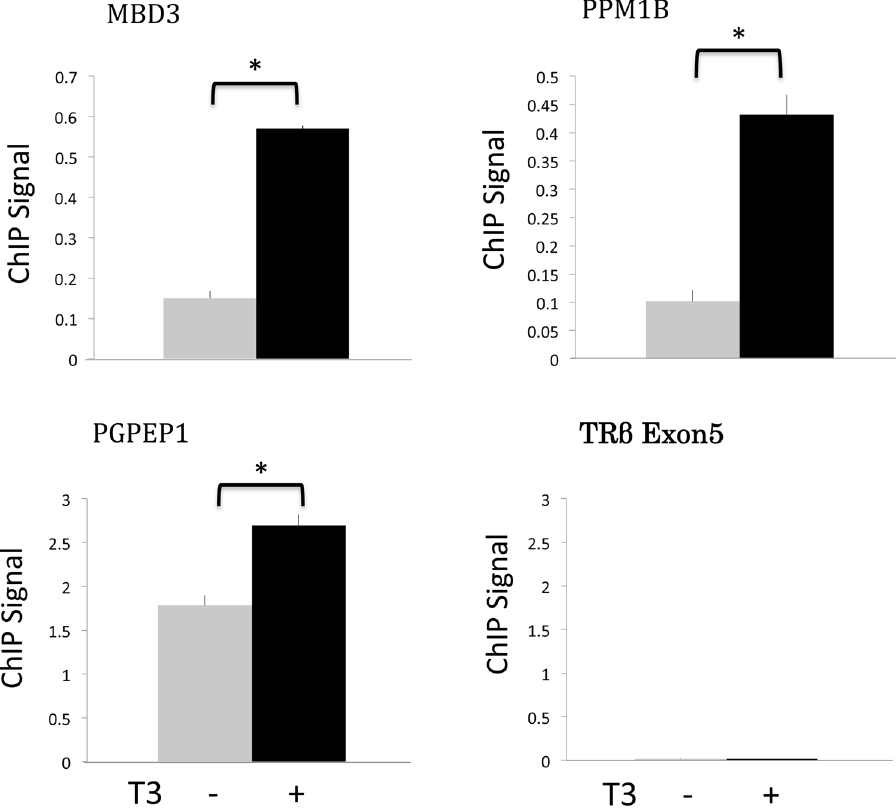
Figure 3. ChIP confirmation of the TR binding to target sites identified from the ChIP-on-chip assay. The intestine from stage 54 tadpoles treated with or without T3 was isolated and subjected to anti-TR antibody ChIP assay and the region around the putative TR binding sites as identified from the ChIP-on-chip assay was PCR amplified. Note that no TR binding was found in the control gene (exon 5 of the TR β gene) while all three newly identified target genes had TR binding in the absence of T3 and this binding was enhanced upon T3 treatment, in agreement with the ChIP-on-chip data. * indicates pairs of samples with significant differences (p <